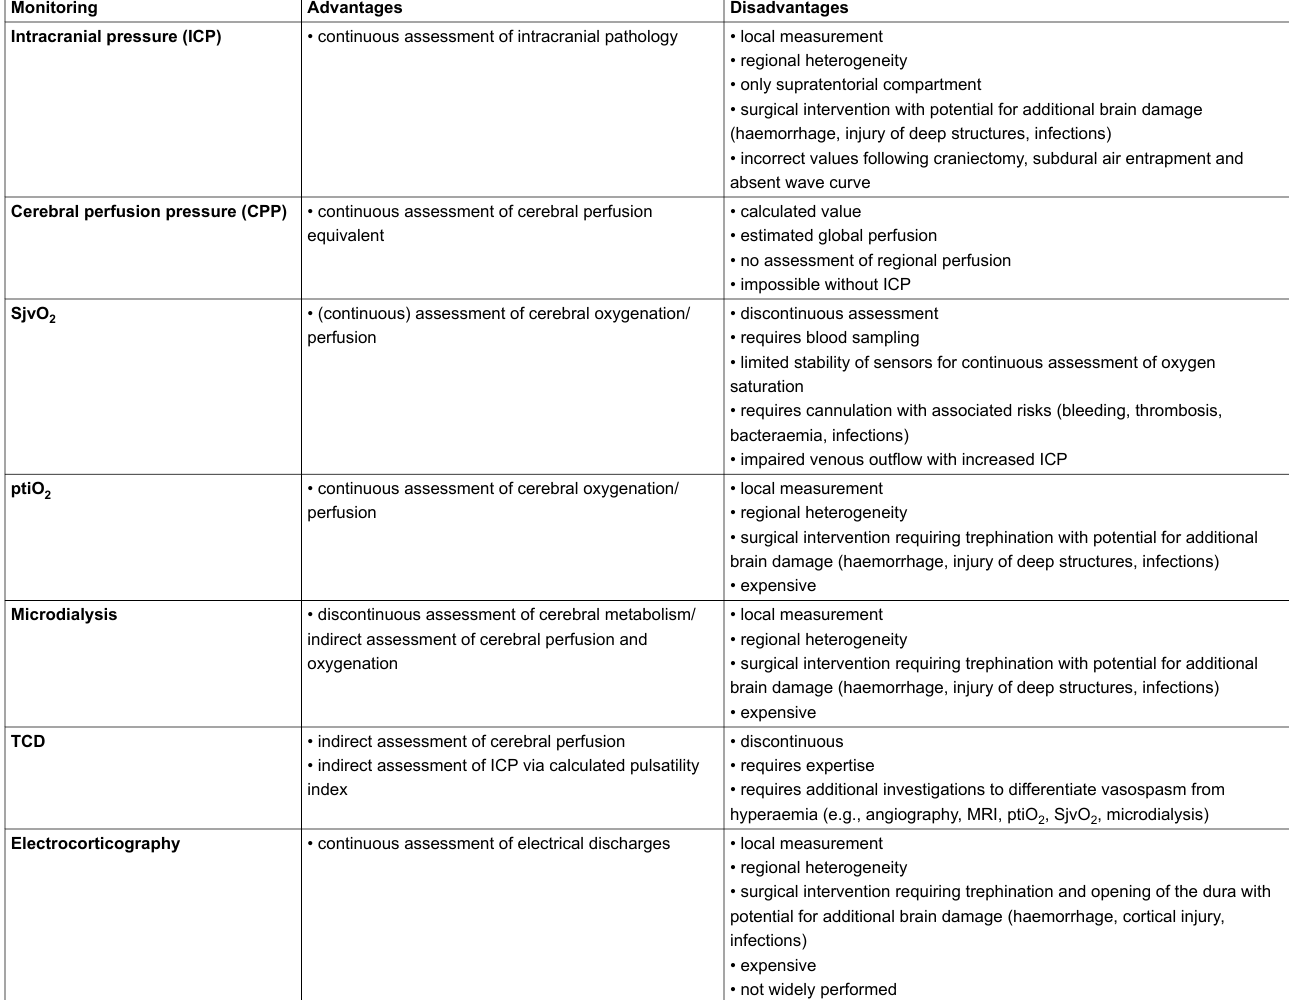
Table 2: Advantages and disadvantages of the different neuromonitoring tools used to guide type, extent, and duration of treatment options.